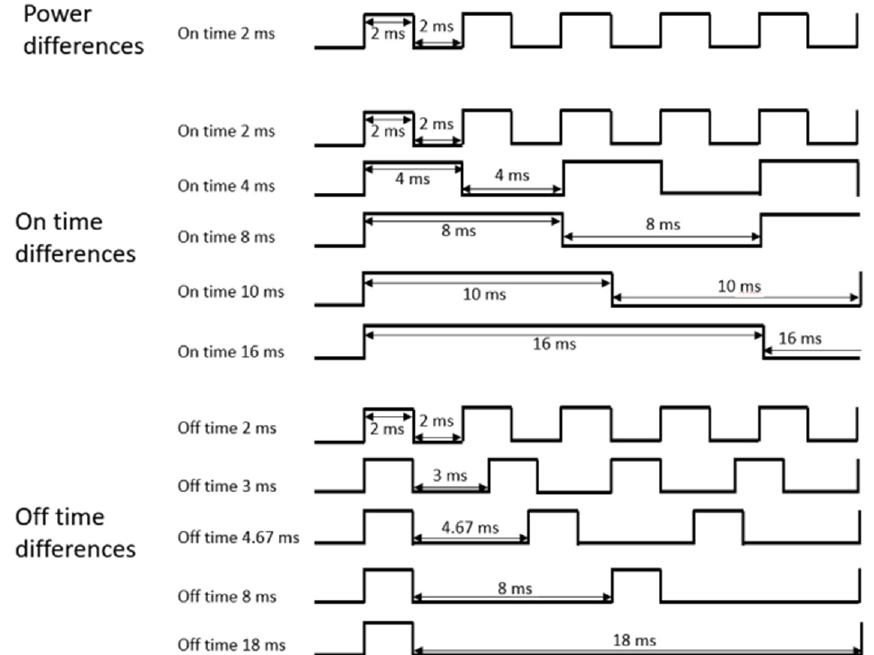
Figure 2. Pulse-modulated power scheme.